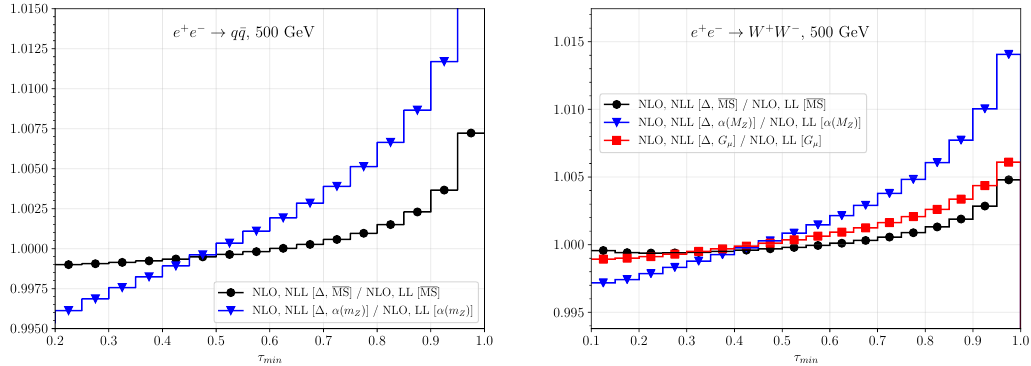
Figure 2 . Ratios of NLO cross sections computed with NLL- ∆ PDFs over those computed with LL PDFs, for different choices of renormalisation scheme. Left panel: q ¯ q production; right panel: W + W − production.